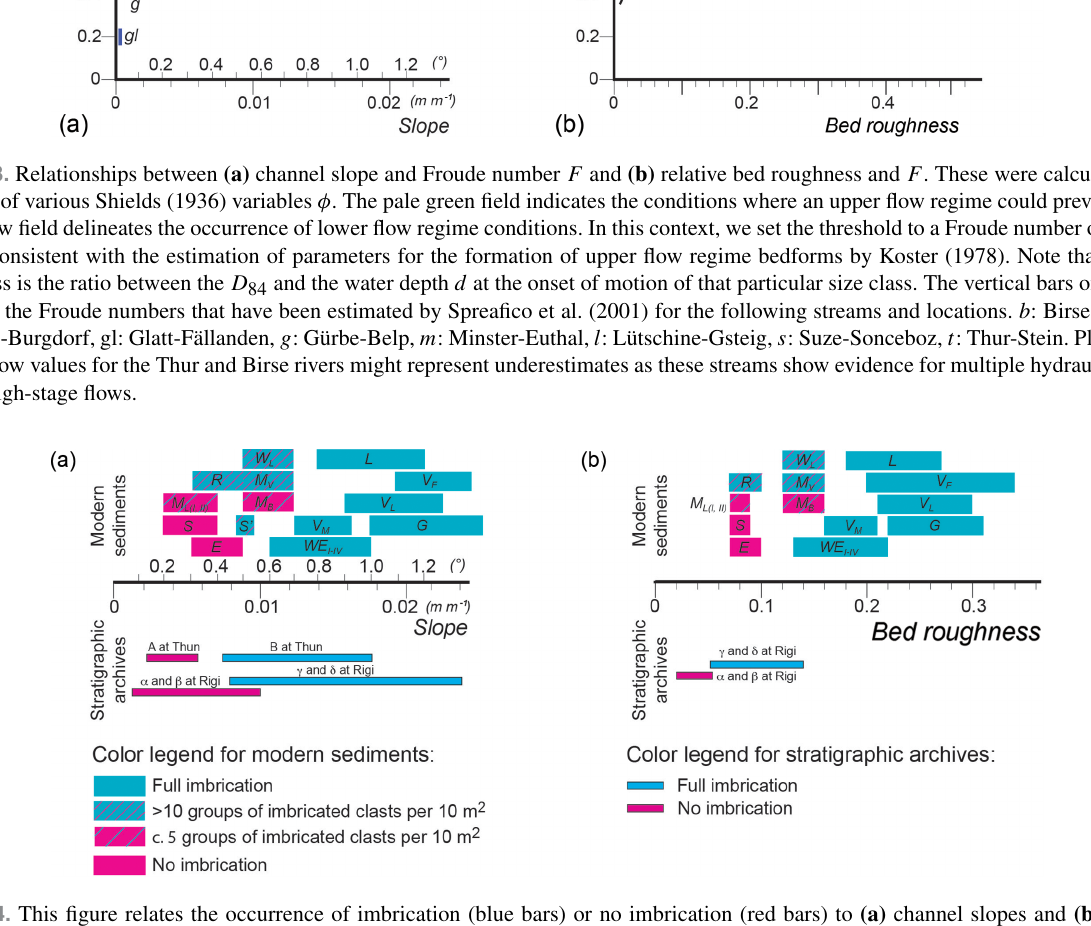
Figure 4. This figure relates the occurrence of imbrication (blue bars) or no imbrication (red bars) to (a) channel slopes and (b) relative bed roughness. Red bars with blue hatches indicate that imbrication has been found in places. Blue bars with red hatches suggest that imbrication dominates the bar morphology, but that reaches without imbrication are also present on the same gravel bar. Data from modern streams are displayed above the horizontal axes, while information from stratigraphic sections are placed below the slope and roughness axes, respectively. S : Sense; S (cid:48) : Sense with bedrock reach; E : Emme; WE I − IV : Waldemme; WL: Waldemme at Littau; R : Reuss; L : Landquart; Table 1 for coordinates of sites and Fig. 2 for locations where data were